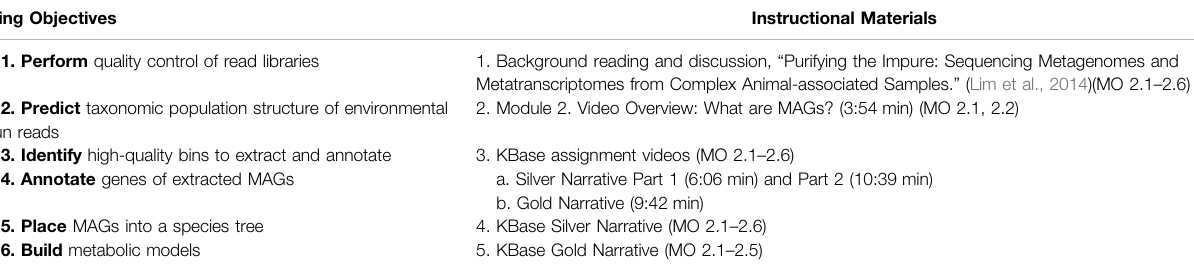
TABLE 1 | Module Learning Objectives (MO) and instructional materials (resources linked within